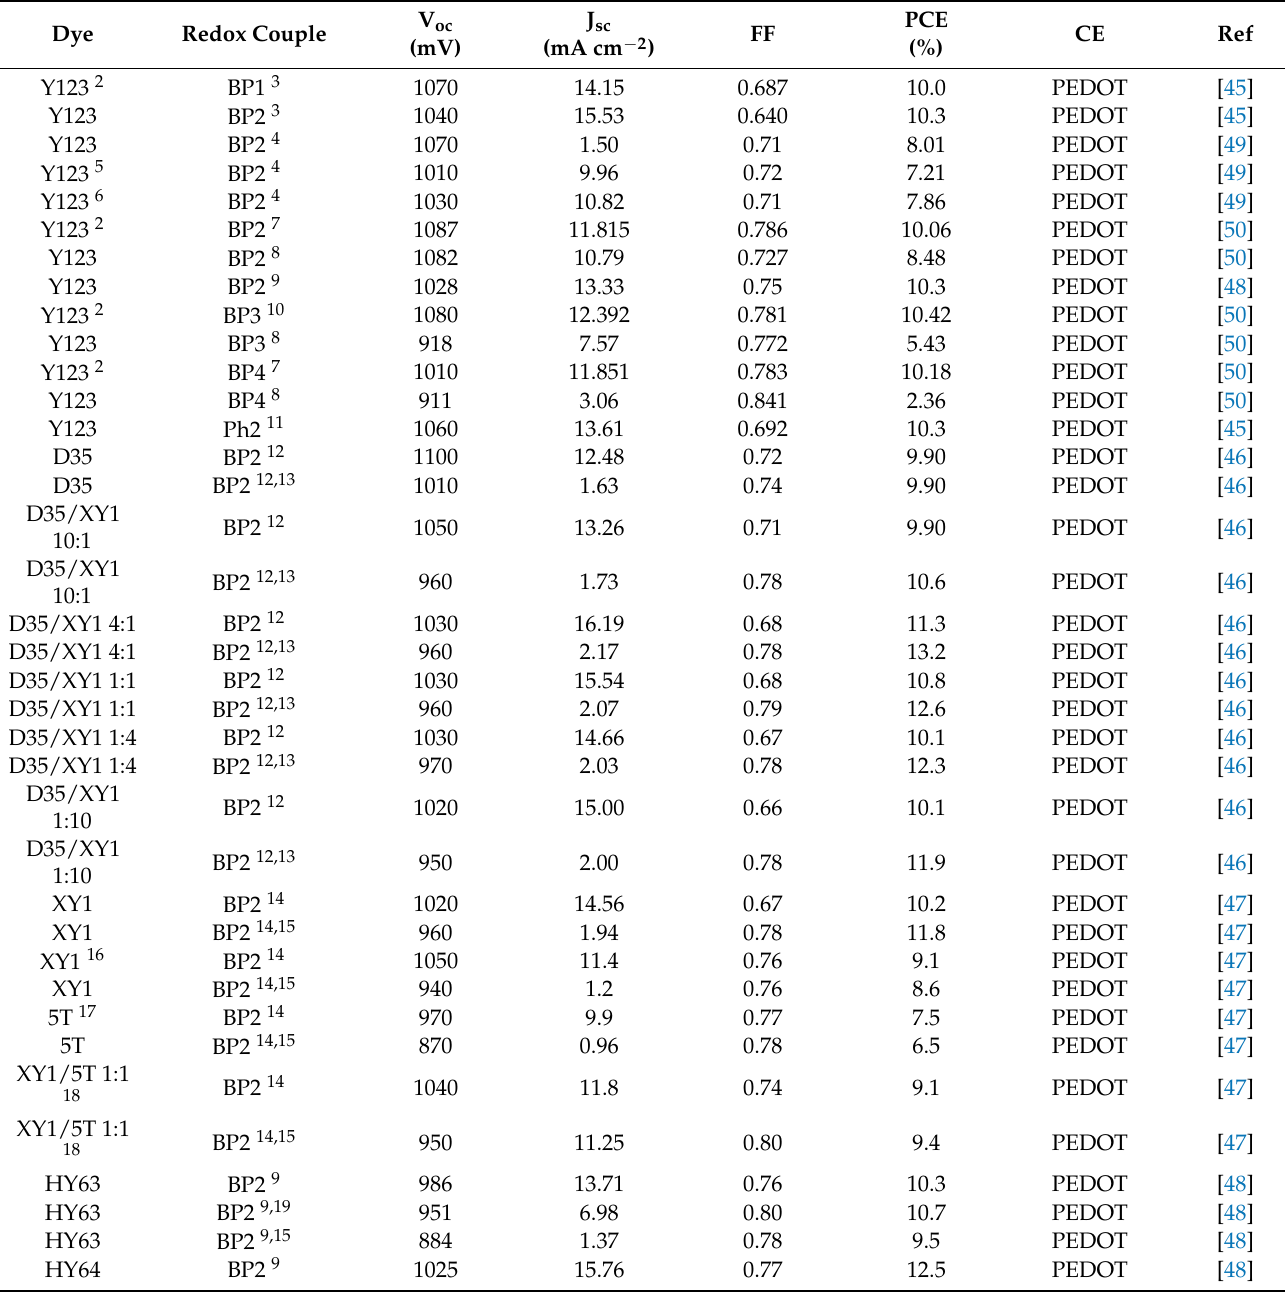
Table 2. Photoelectrochemical data of solar cells filled with bipyridine copper complexes as redox mediators.